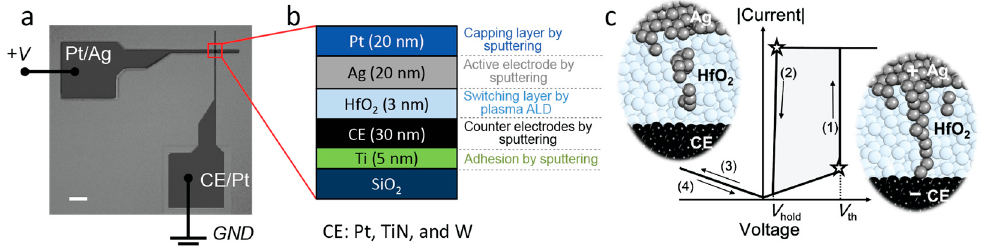
Figure 1. ( a ) Optical micrograph of a fabricated crossbar structure of an Ag/HfO 2 /CE device with CE = Pt. Scale bar 10 μ m. ( b ) Schematic of the fabricated device stack at the crossing point of the top and bottom electrodes. ( c ) Representation of the switching characteristics and mechanism of a diffusive memristor.